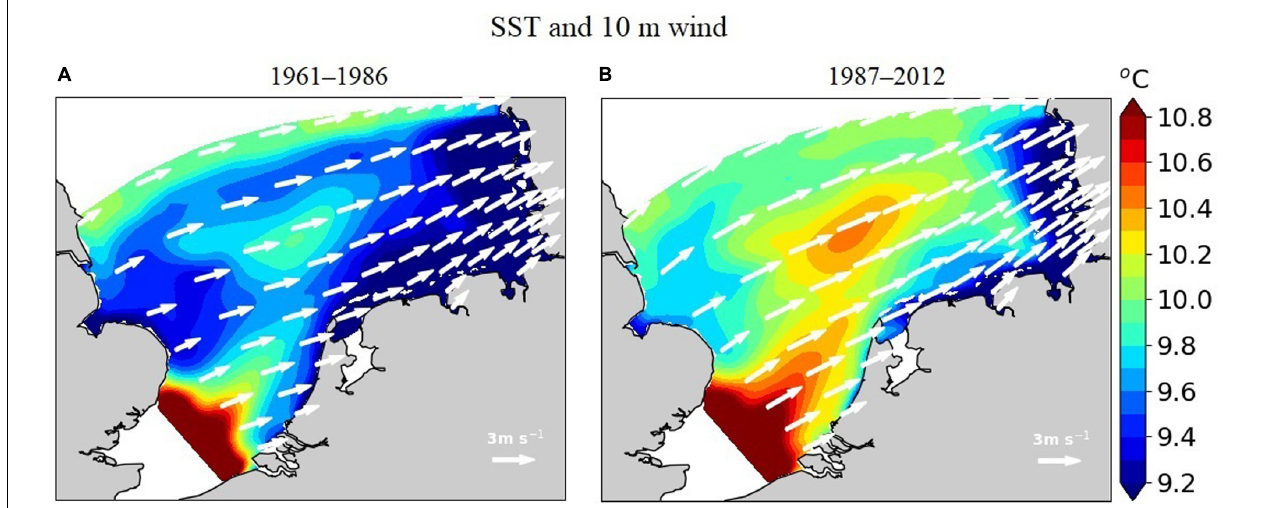
FIGURE 6 | Simulated mean sea surface temperature and 10-m wind speed in (A) 1961–1986 and (B) 1987–2012.